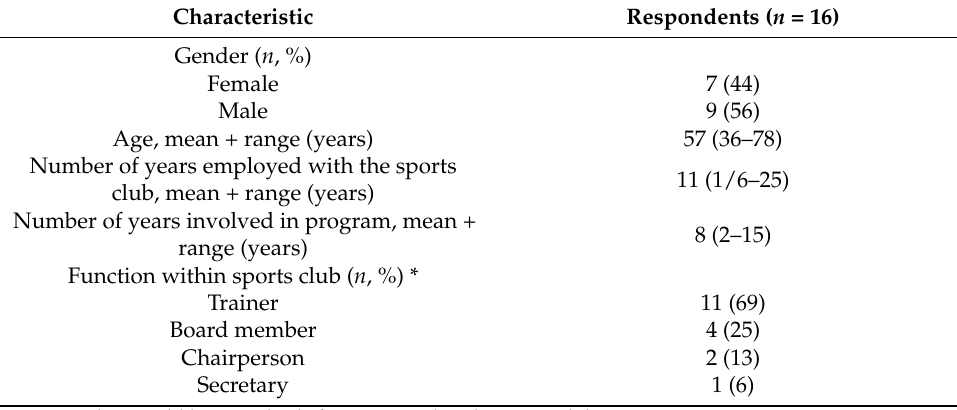
Table 2. Descriptive characteristics of respondents.